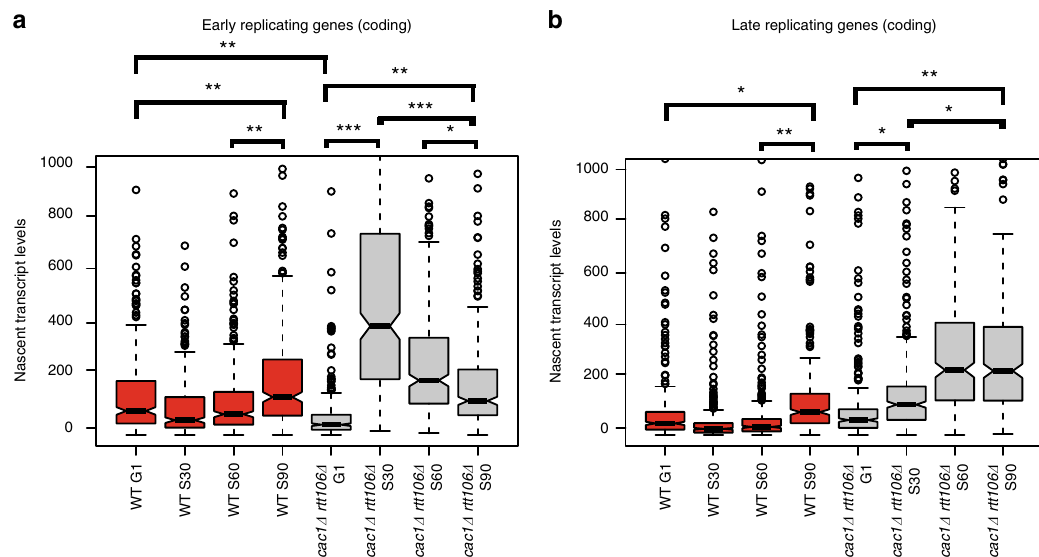
Fig. 5 Delayed nucleosome assembly affects transcription during S phase. a , b Boxplots showing nascent transcript levels at different time points (G1, S30, S60, and S90) between wild type (red) and cac1 Δ rtt106 Δ (gray) for early replicating genes ( a ) or late-replicating genes ( b ) for coding regions. The lateral lines in the boxes represent the median, and separate upper and lower quartiles. The vertical lines represent the highest and lowest data points. Signi fi cance and p values were calculated by using Mann – Whitney U test. Error bars represent standard